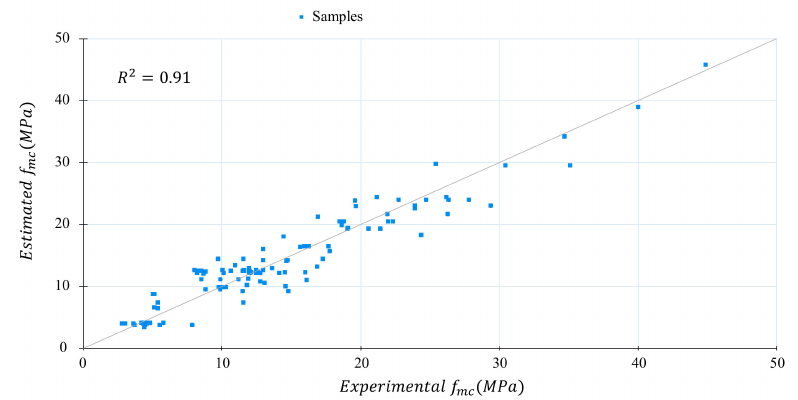
Figure 9. Comparison between simplified symbolic regression model and experimental data.